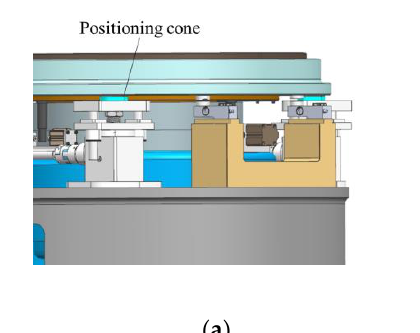
Figure 15. (a) The schematic of MOI measurement state.; ( b ) The detail view of MOI measurement state.